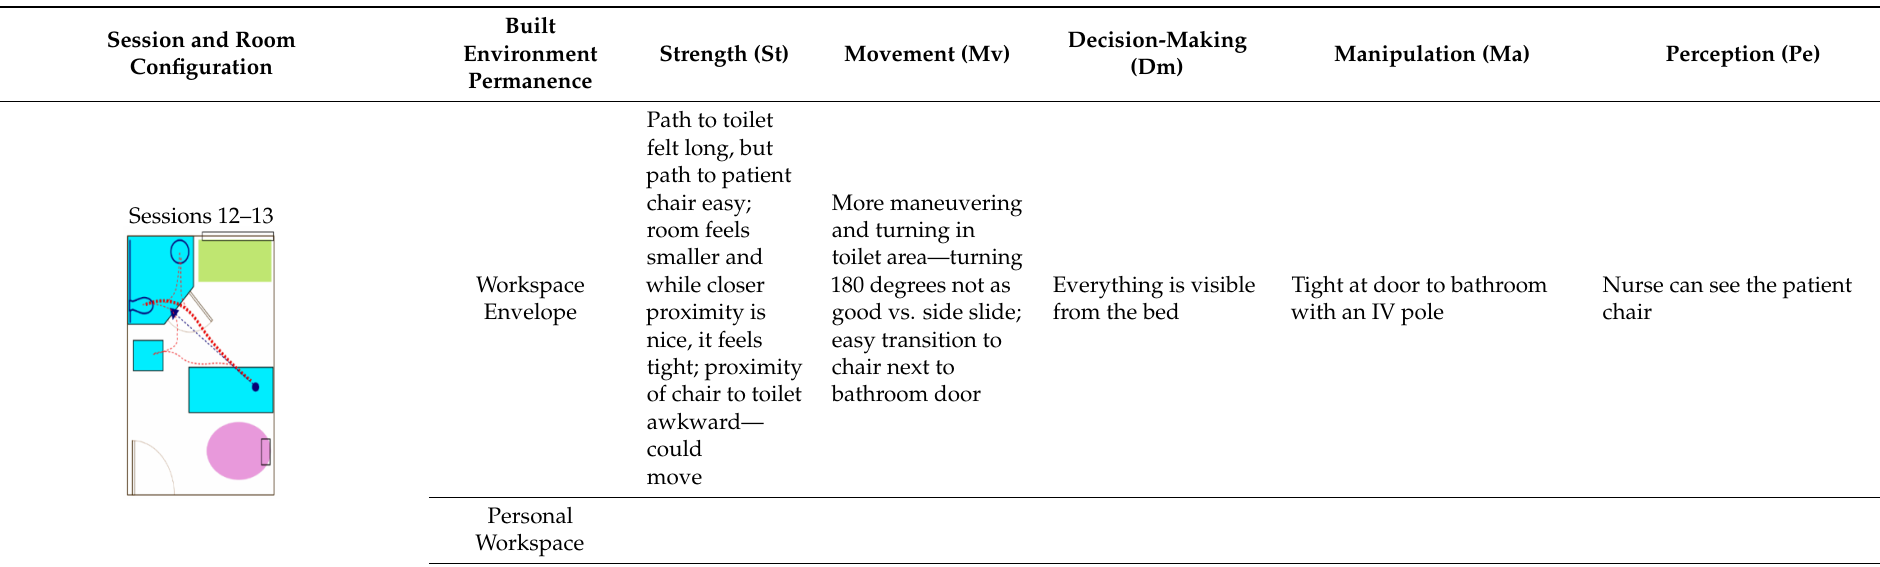
Table 7. Session 12–13 Feedback (Room 6—Outboard